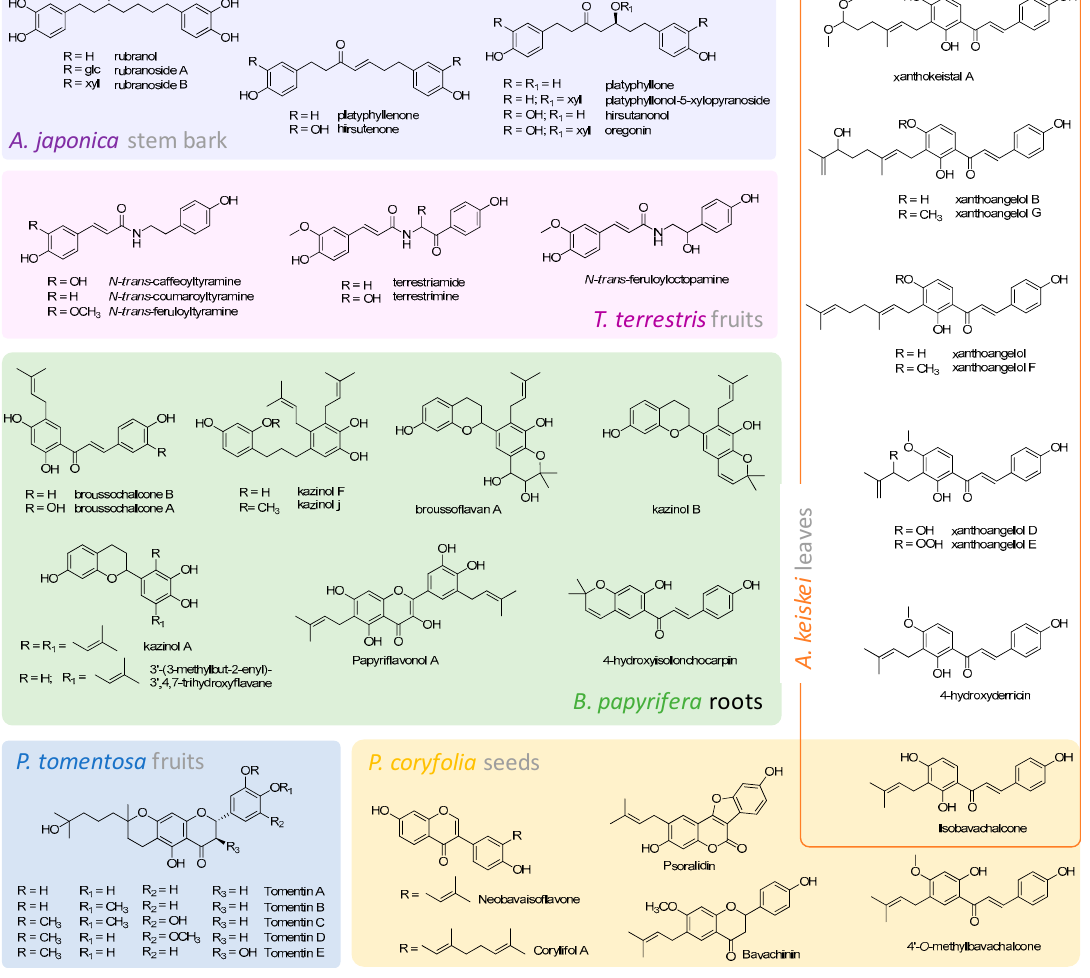
Figure 6. Chemical structures and related plant sources of some promising natural compounds with PLpro inhibiting activity.